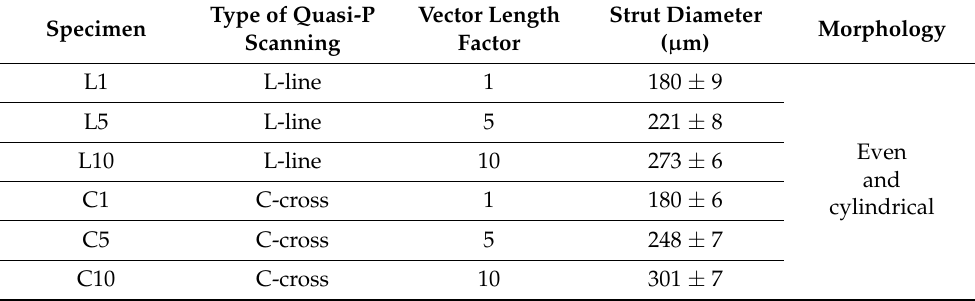
Table 1. Summary of the filigree specimens produced for µ CT analysis (Section 3.2) and microme- chanical testing (Section 3.3). The nomenclature is related to the type of scanning (sequence, line length). The corresponding strut diameters measured by optical microscopy are also listed. Type of Quasi-P Vector Length Strut Diameter Morphology Specimen Scanning Factor ( µ m) L1 L-line 1 180 ± 9 cylindricalL5 L-line 5 221 ± 8 Even L10 L-line 10 273 ± 6 and C1 C-cross 1 180 ± 6 C-cross 248 ± 7 C-cross 10 301 ±